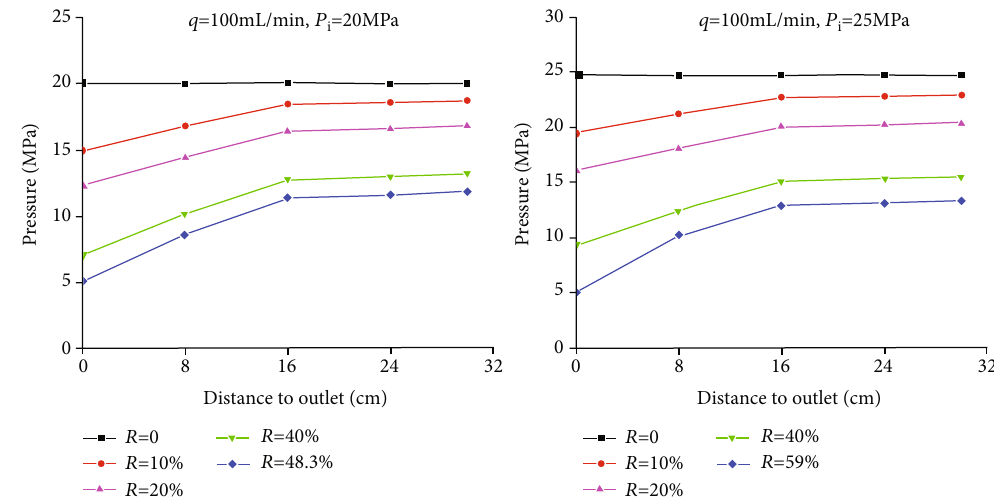
Figure 6: Comparisons of reservoir utilization in the Su3 core under di ff erent initial reservoir pressures.